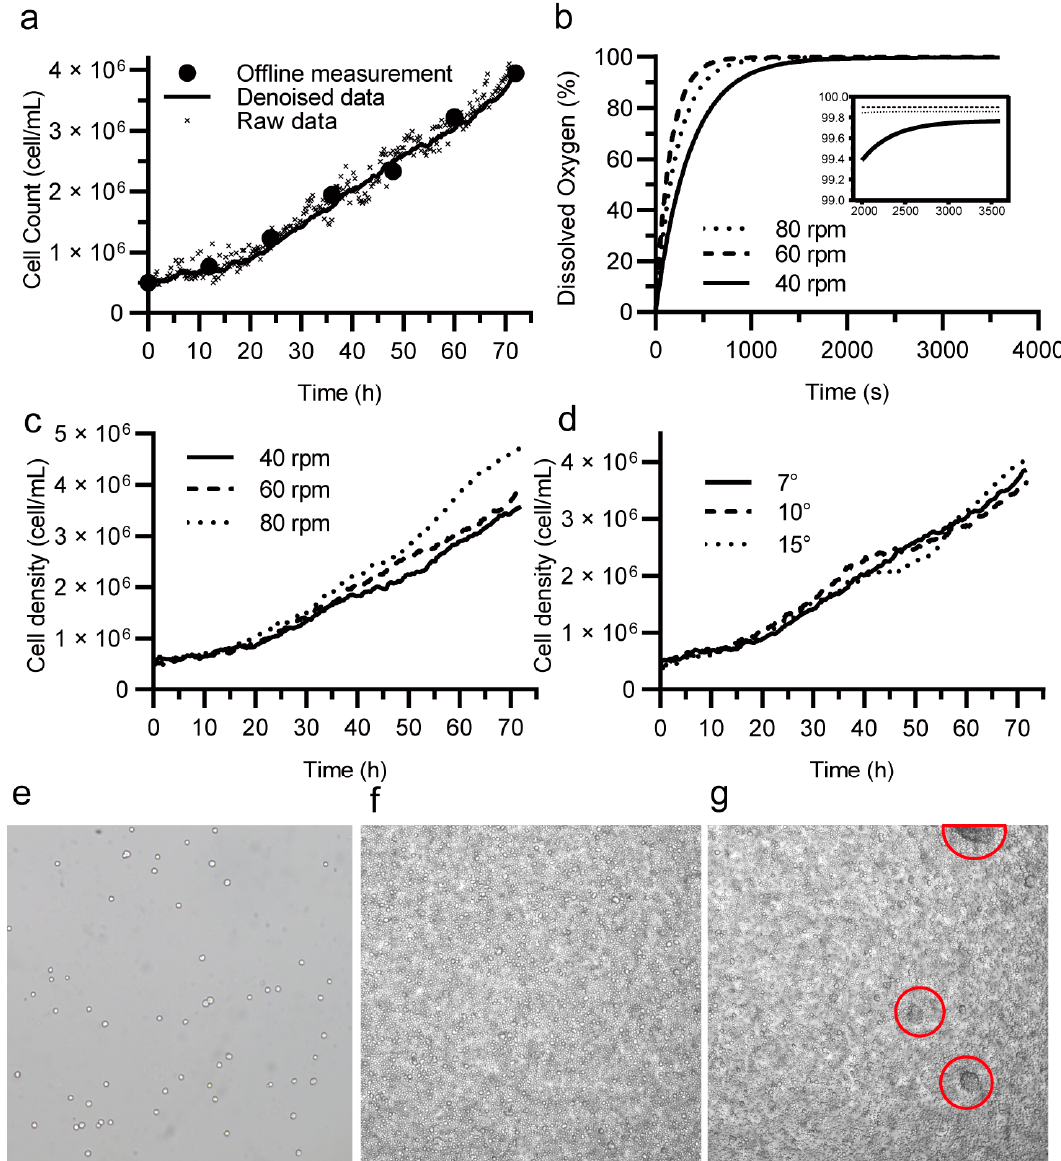
Figure 4. ( a ) Validation of the cell density sensor with a Kalman filter. ( b ) Simulation results of changes in dissolved oxygen at 40, 60 and 80 rpm and 7° rocking angle. ( c ) Changes in cell density at 40, 60 and 80 rpm and 7° rocking angle. ( d ) Cell growth at 7°, 10° and 15° rocking angle and 60 rpm speed. ( e ) Microscopic image of cells’ morphological status. ( f ) Microscopic image of cells performing periodical 90° rotation. ( g ) Microscopic image of cells not performing periodical 90° rotation.